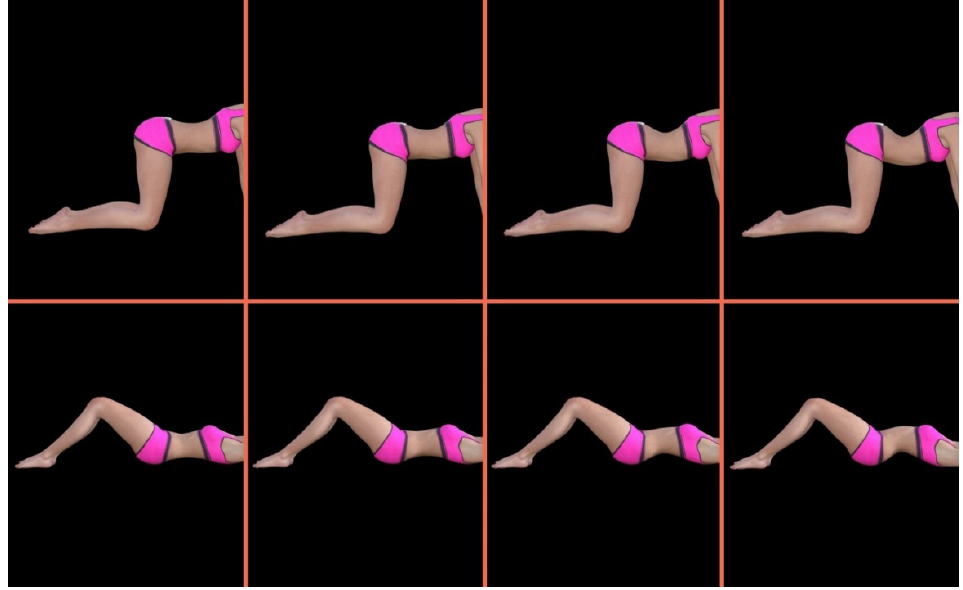
Figure 1. Female stimuli in quadruped ( upper row ) and supine postures ( lower row ). Stimuli were randomly presented in two separate blocks, each containing either the quadruped or the supine